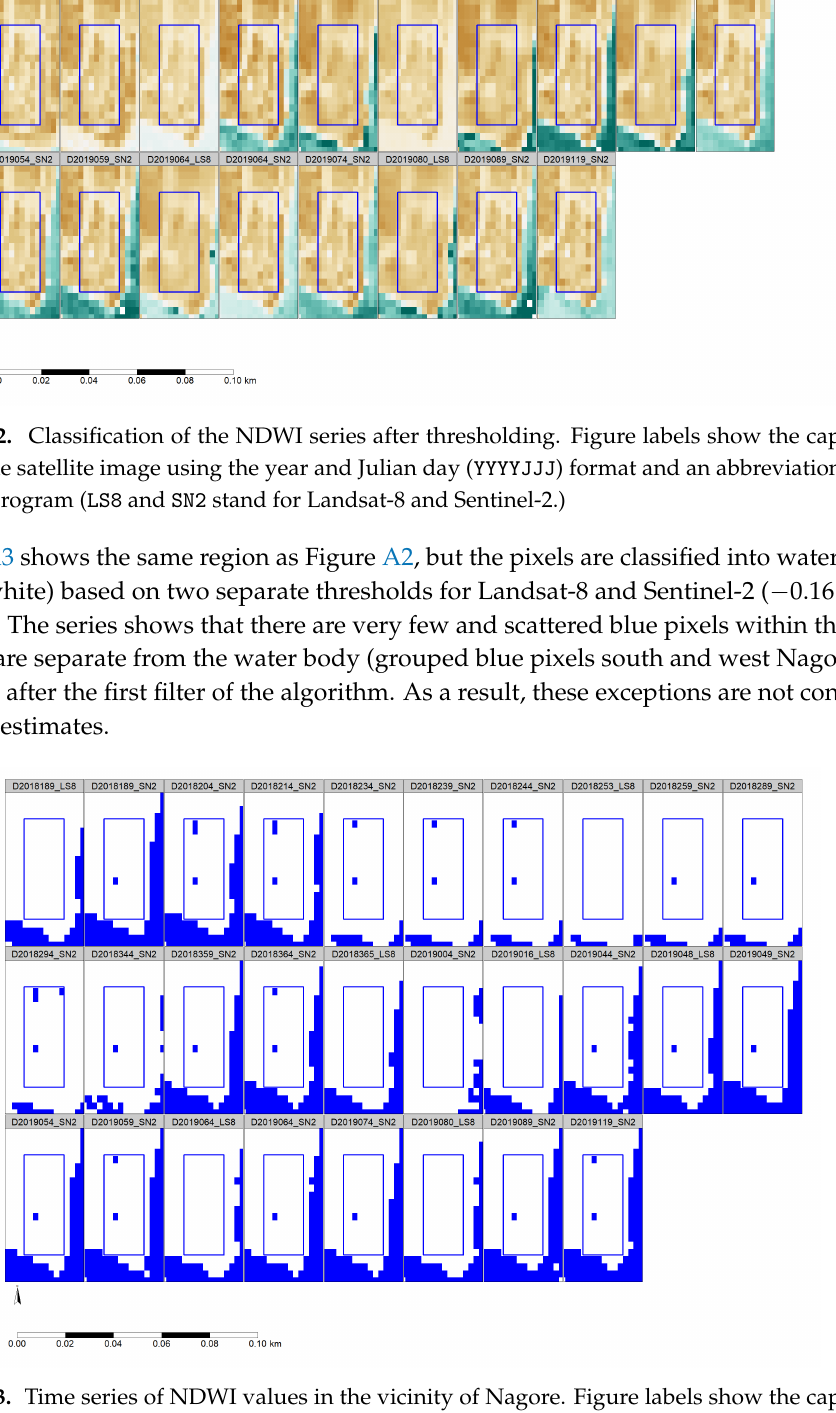
Figure A3. Time series of NDWI values in the vicinity of Nagore. Figure labels show the capturing date of the satellite image using the year and Julian day ( YYYYJJJ ) format and an abbreviation of the satellite program ( LS8 and SN2 stand for Landsat-8 and